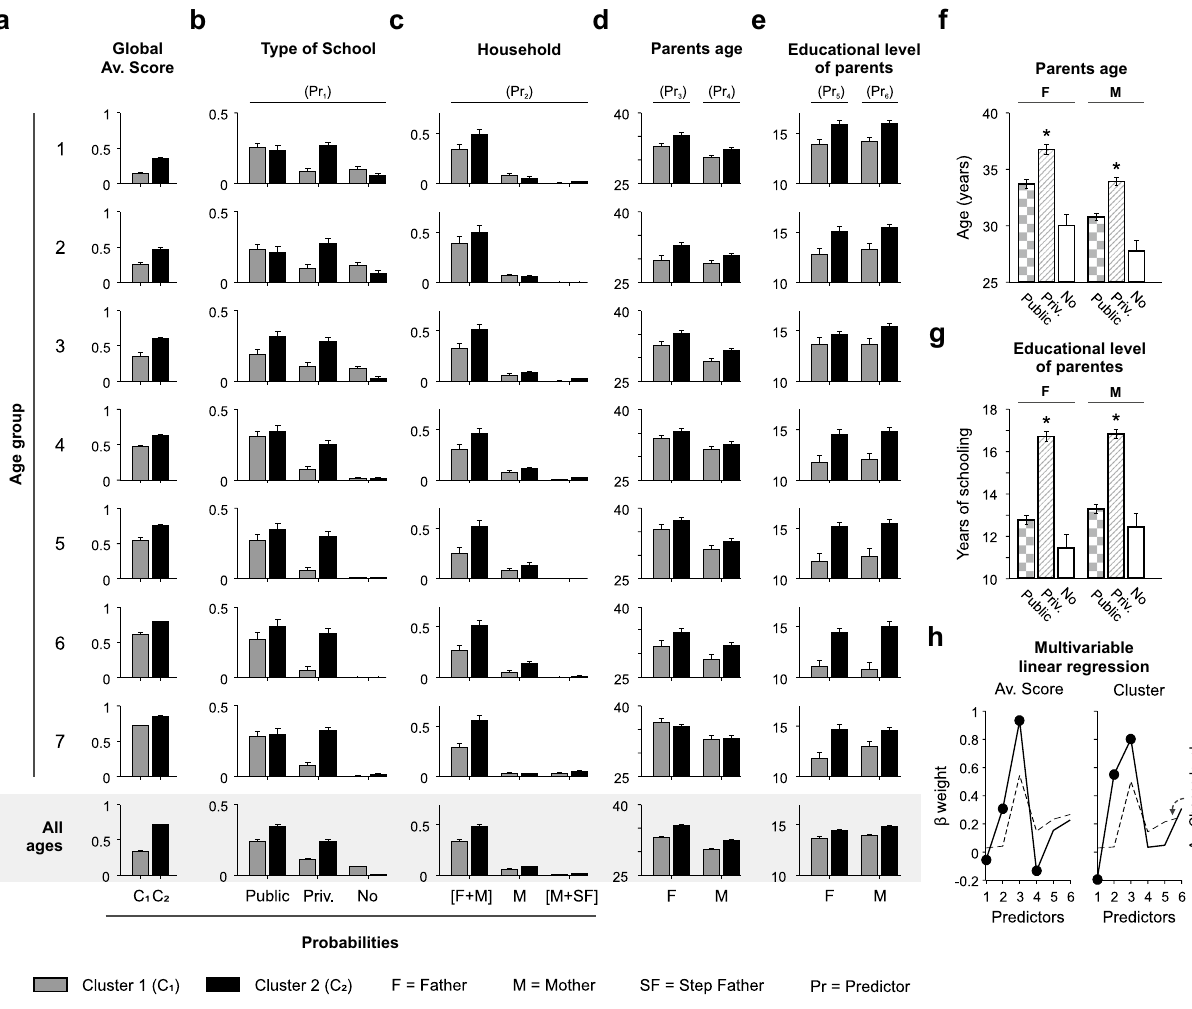
Figure 3. Influence of domestic and educational factors on cluster classification. ( a ) Global scores (i.e., the average from all tests) for the participants from cluster 1 (C 1 , in gray) and cluster 2 (C 2 , in black). ( b ) Probabilities that children from C 1 and C 2 went to public, private, or no-school (Predictor 1: Pr 1 ). ( c ) Probabilities that children from C 1 and C 2 lived with both parents, only with the mother or with mother and stepfather (Pr 2 ). ( d ) Average age of fathers (left, Pr 3 ) and mothers (right, Pr 4 ) of children from C 1 and C 2 . ( e ) Average years of schooling of fathers (left, Pr 5 ) and mothers (right, Pr 6 ) of children belonging to C 1 and C 2 . Average age ( f ) and average years of schooling ( g ) of fathers (left) and mothers (right) of children attending public, private, or no-school. ( h ) Multivariate regression model exploring how the six predictors (Pr 1–6 ) influenced cluster assignment (significant regression weights marked with filled